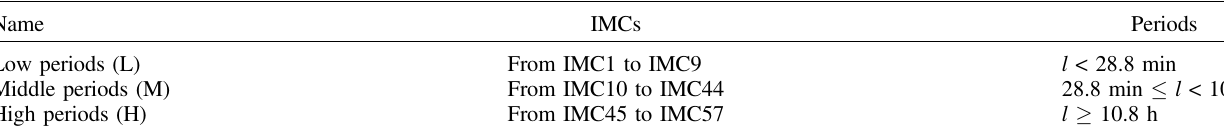
Table 1. Range of periods and corresponding IMCs.